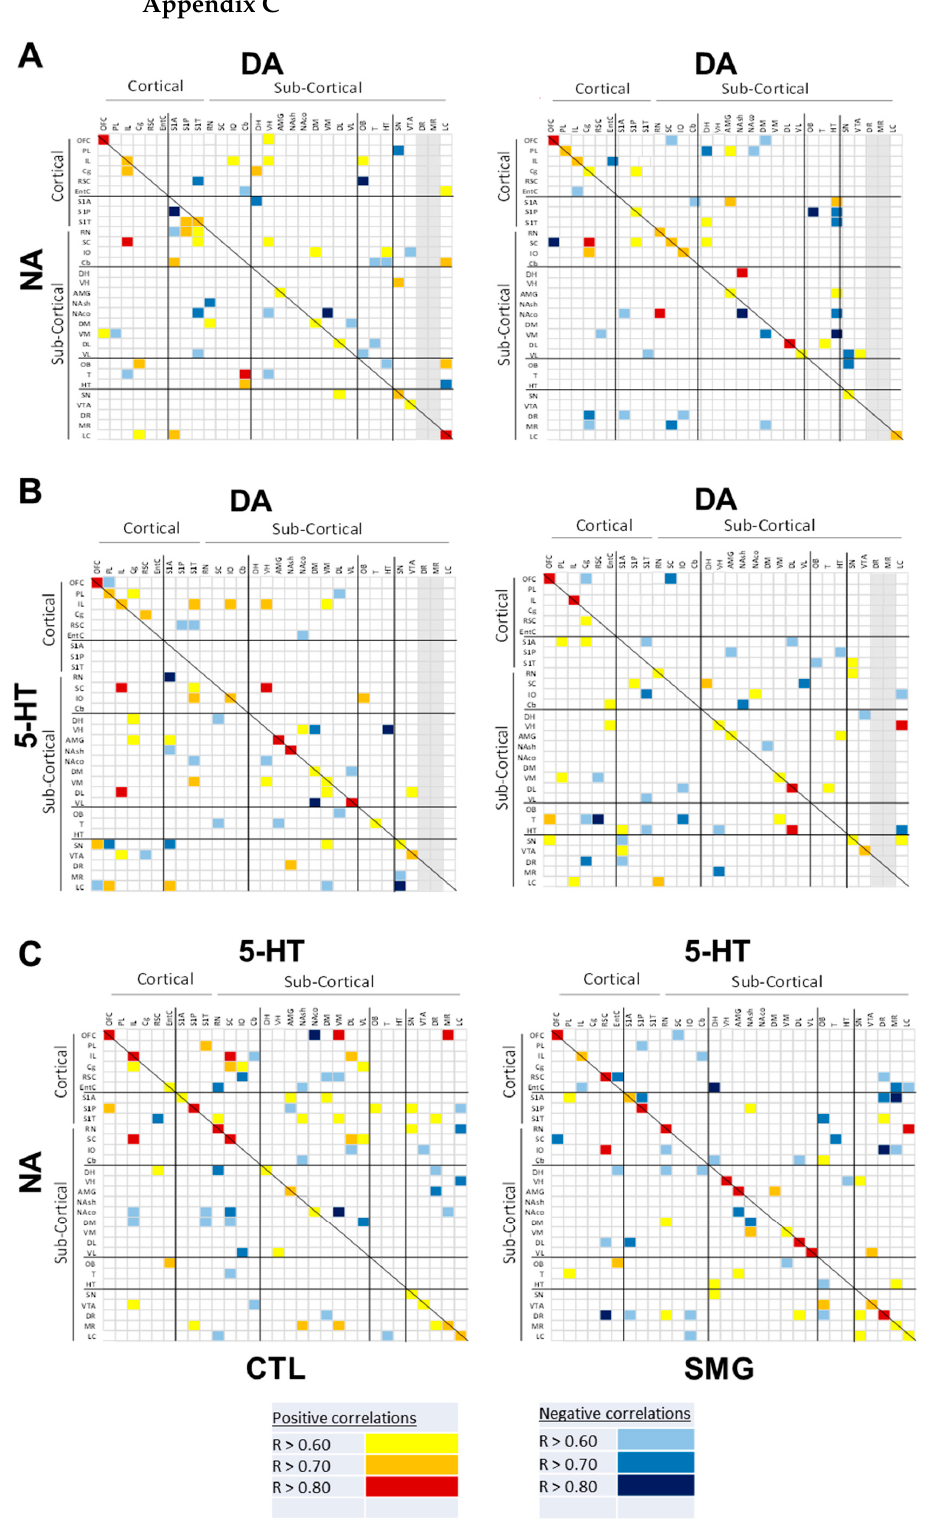
Figure A3. Correlations established between the NA and DA content ( A ), 5-HT and DA content ( B ), and NA and 5-HT content ( C ) in the brain. Positive correlations are reported in yellow (r > 0.6) to red (r > 0.8). Negative correlations are reported in light blue (r < − 0.6) to deep blue (r < − 0.8). Only significant correlations ( p < 0.05) are